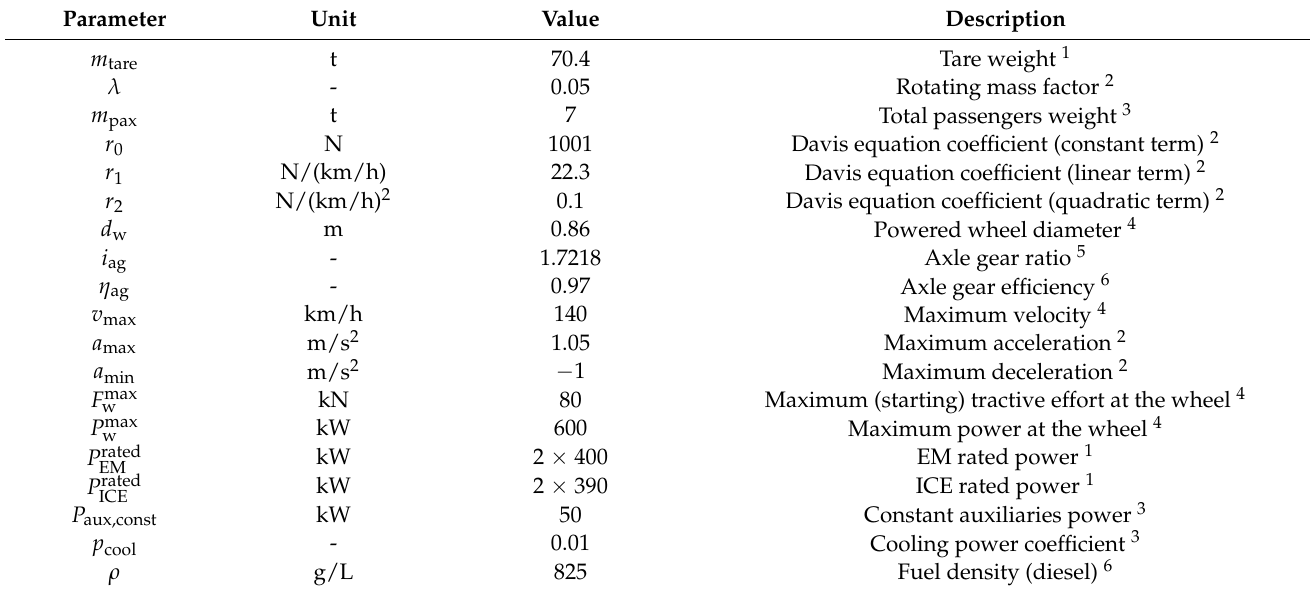
Table 1. Standard GTW 2/6 DEMU simulation